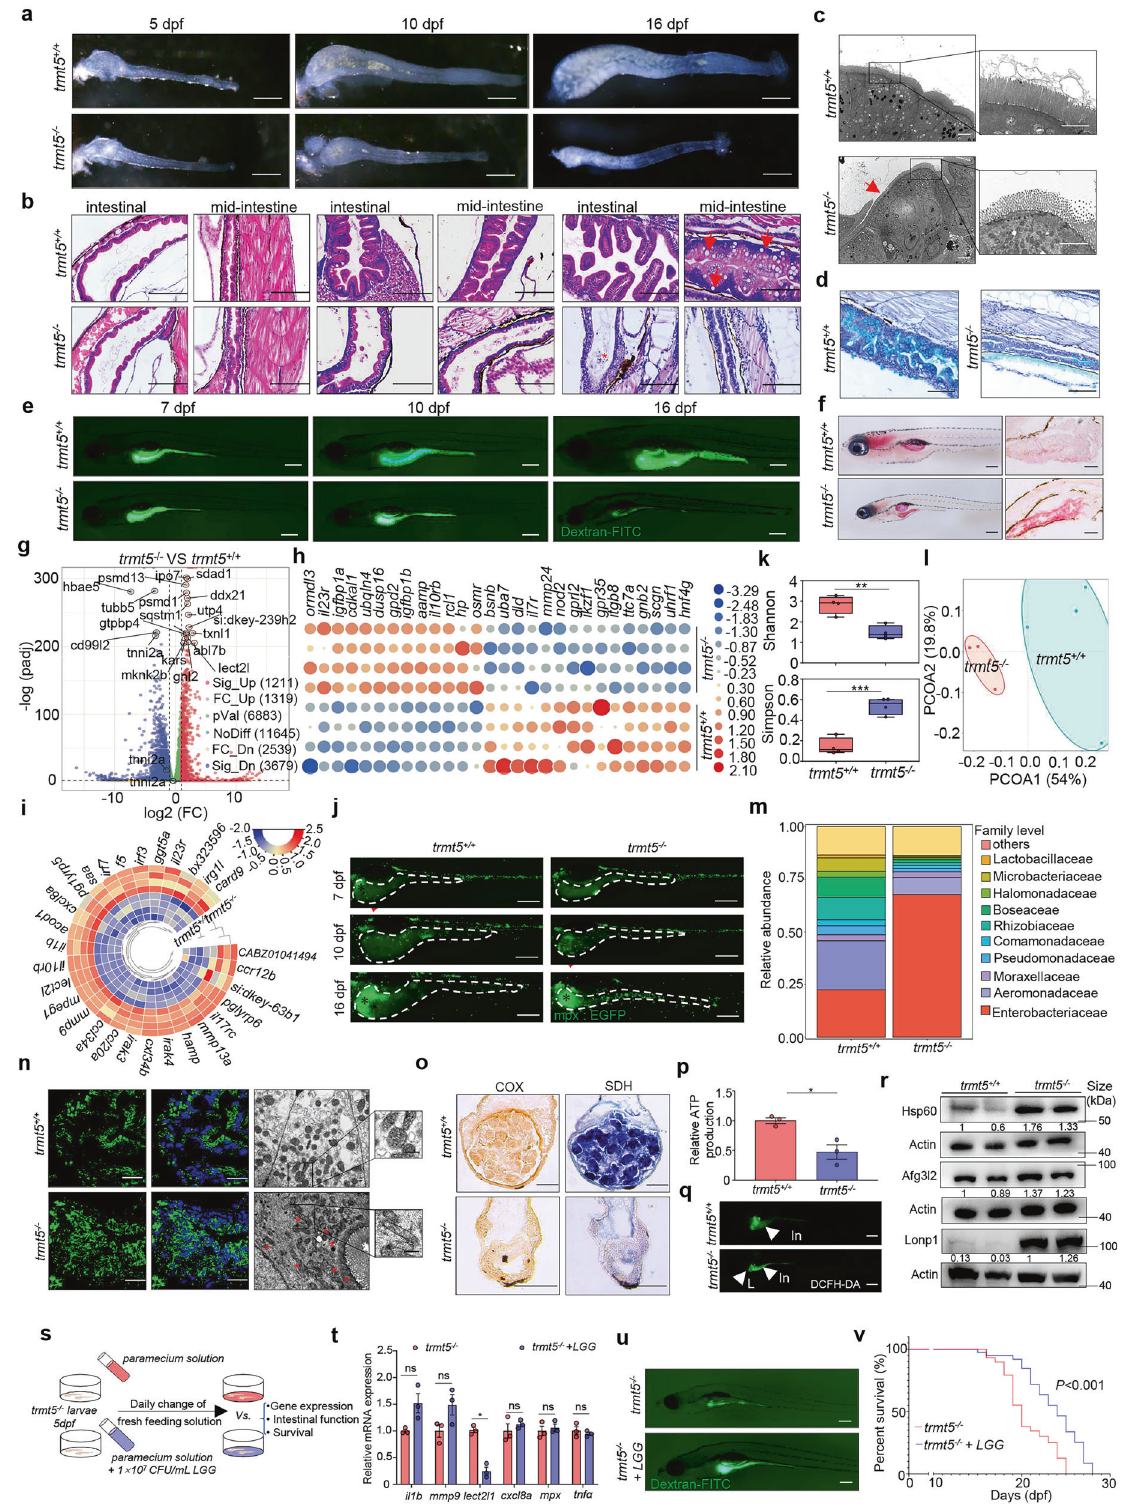
expressed differently in trmt5 − / − mutants, among which 91 were downregulated and 44 were upregulated (Supplementary Fig. 10a). GO analysis indicated that the most signi fi cant number of genes enriched in oxidation-reduction process (Supplementary Fig. 10b). The protein expression levels of representative